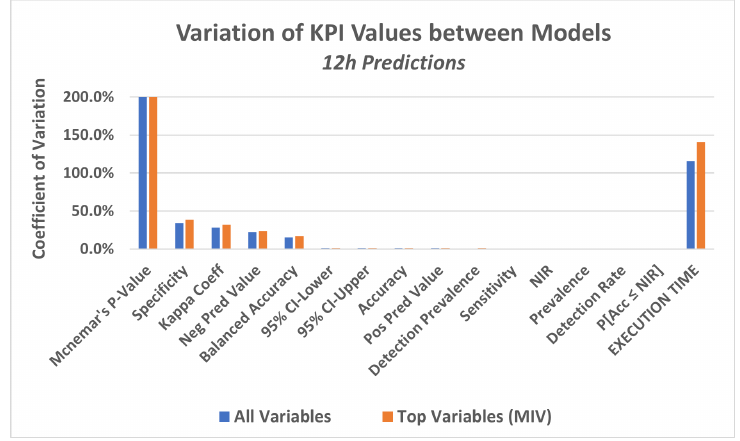
Figure 13. Variation in KPI Values between Models expressed by CV—12 h Predictions.